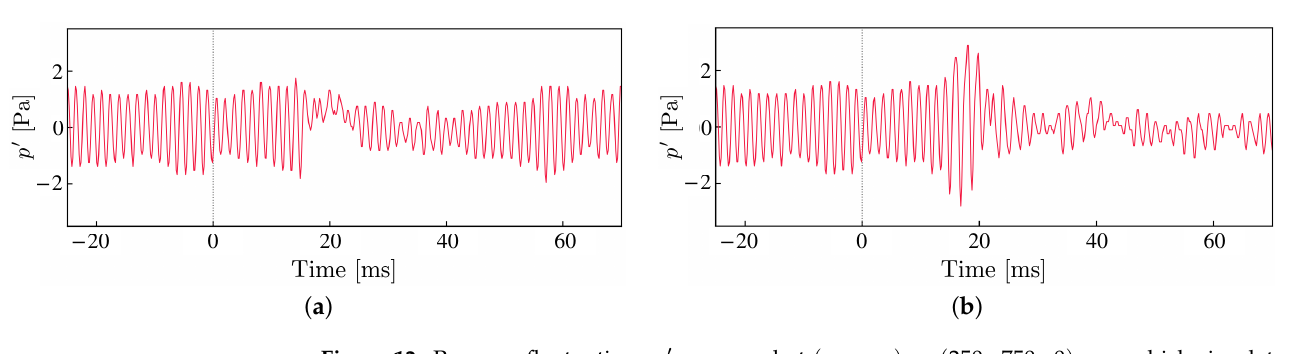
Figure 12. Pressure fluctuations p (cid:48) measured at ( x , y , z ) = ( 250, 750, 0 ) mm which simulate a microphone at ( r , θ ) = ( 750 mm, π /2 ) in wind tunnel test. ( a ) Narrow; ( b ) Wide.